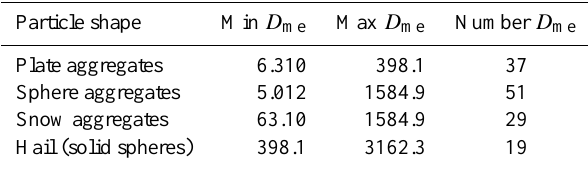
Table B1. Range of ice water content weighted equivalent sphere